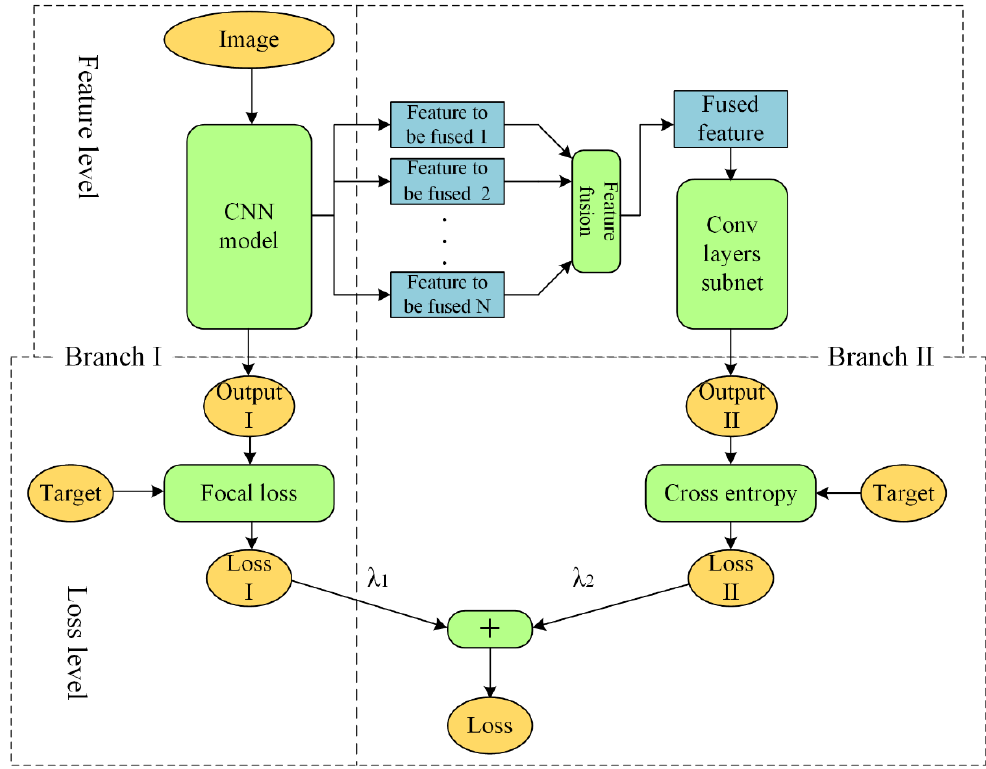
Figure 1. Dual branch network architecture. As for separating it from up to down, the entire architecture can consider as a fusion strategy that adopts both early fusion (up) and late fusion (down) at the level of feature and loss, respectively.